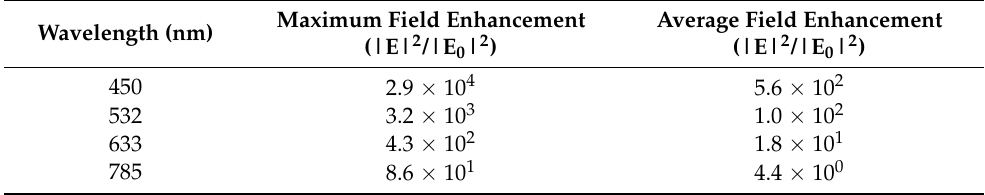
Figure 3. Finite difference time domain (FDTD) simulations of the electric field distribution (|E| 2 /|E 0 | 2 ) at the junctions of crossed Ag NWs, using the wavelengths ( a ) 450 nm, ( b ) 532 nm, ( c ) 633 nm, and ( d ) 785 nm. The k and E vectors in the figure show the incident direction and the polarization direction of the illumination, respectively. The white lines are used to indicate the boundaries of Ag NWs. All scale bars indicate 20 nm. Table 1. Maximum and average field enhancement of crossed Ag NWs at different wavelengths.